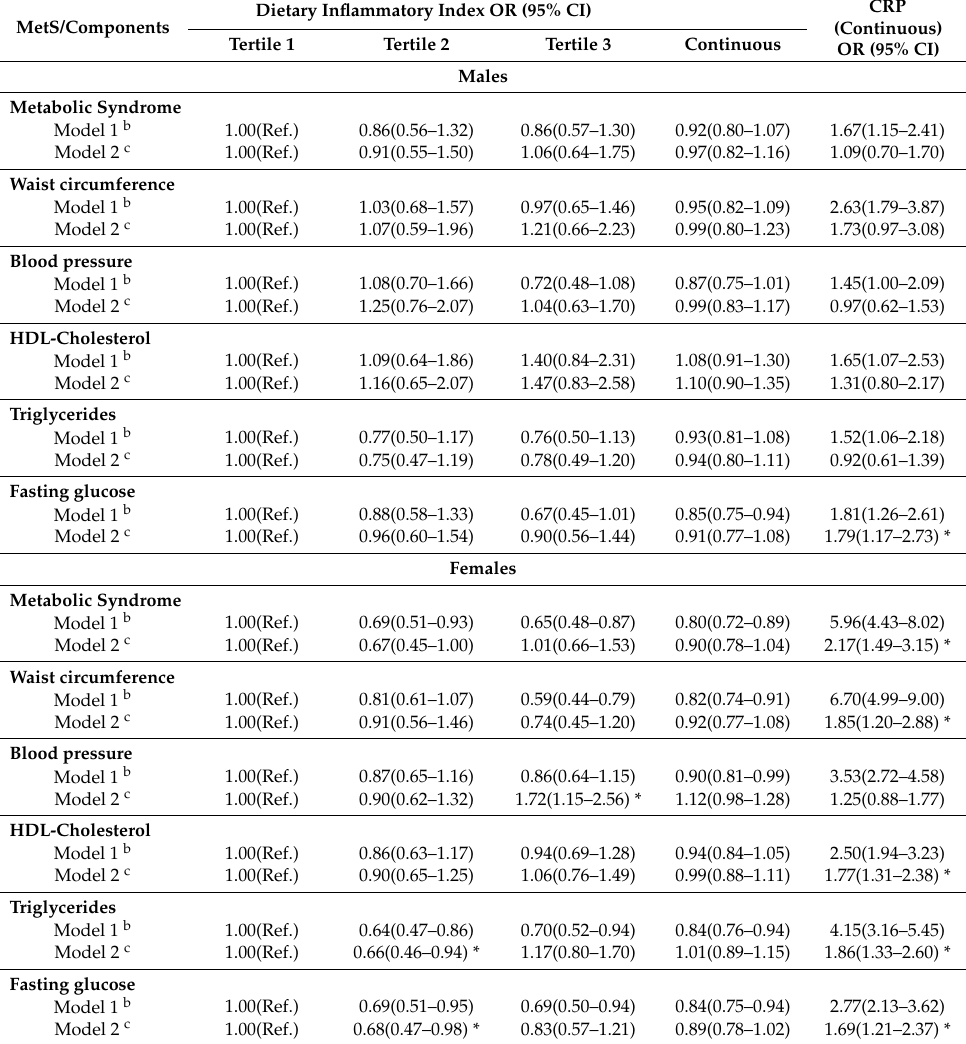
Table 4. Stratified analysis of association between the incidence of MetS (components) and DII/CRP a by